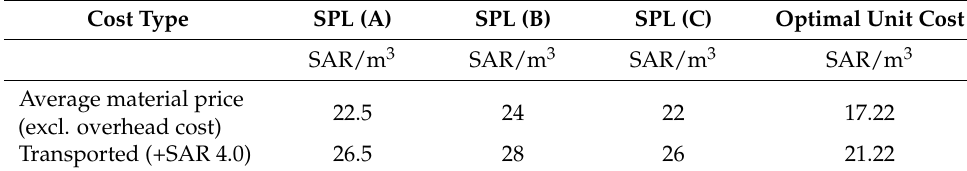
Table 5. The optimal unit discount cost C ji vs. the cost gained from reference